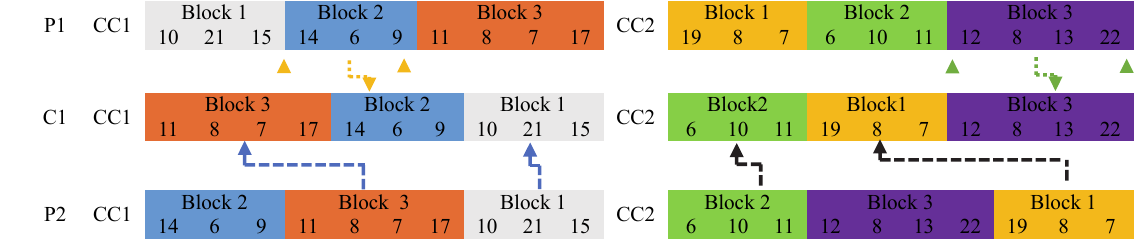
Algorithm 3 . Mutation operator: